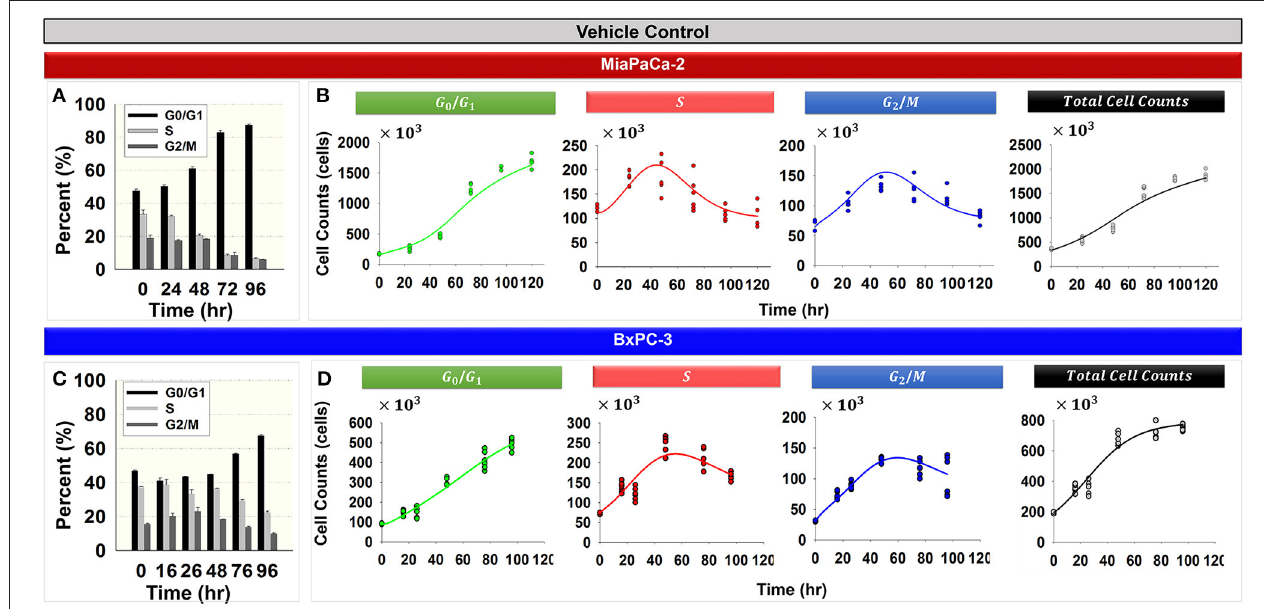
FIGURE 2 | Cell cycle phase distributions in the vehicle control groups for MiaPaCa-2 and BxPC-3 cells. (A,C) Percent of cells in G 0 / G 1 , S , and G 2 / M phases at 0, 24, 48, 72, and 96 h (MiaPaCa-2) and 0, 16, 26, 48, 72, and 96 h (BxPC-3) for vehicle control groups. Columns , mean of triplicate; bars , SD. N = 3. (B,D) Data and model fitting of vehicle control groups. Numbers of cells in G 0 / G 1 , S , and G 2 / M phases, as well as total cells over time, are represented by symbols. Model fittings based on the model of Figure 1B are indicated by lines.